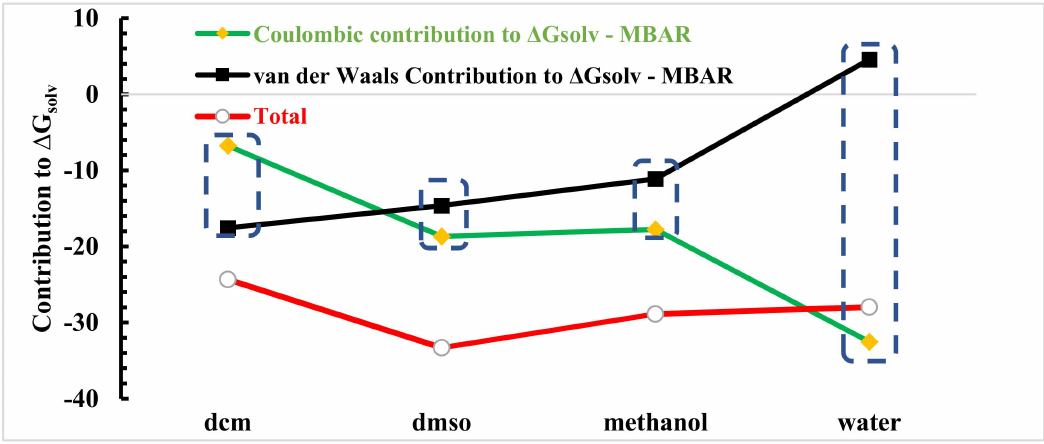
Figure 11. Decomposition of the MBAR ∆ G solv in van der Waals and coulombic contribution functions (in units of